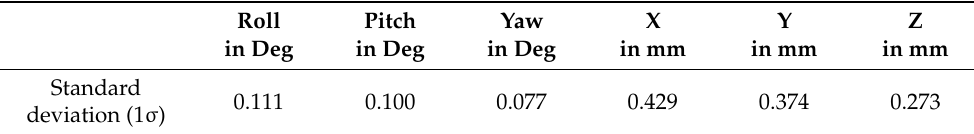
Table 4. Standard deviations resulting from six pose measurements.